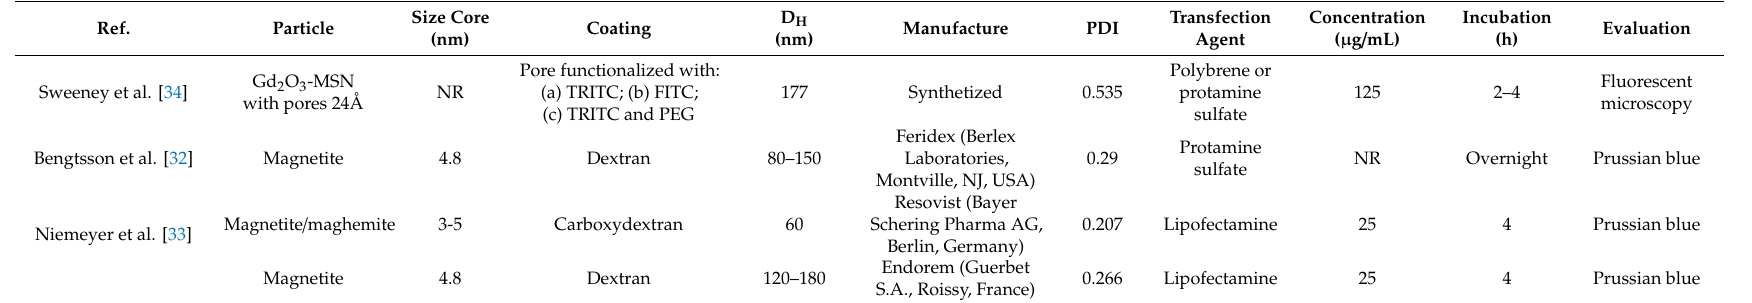
Table 5. Labeling of hematopoietic stem cells with